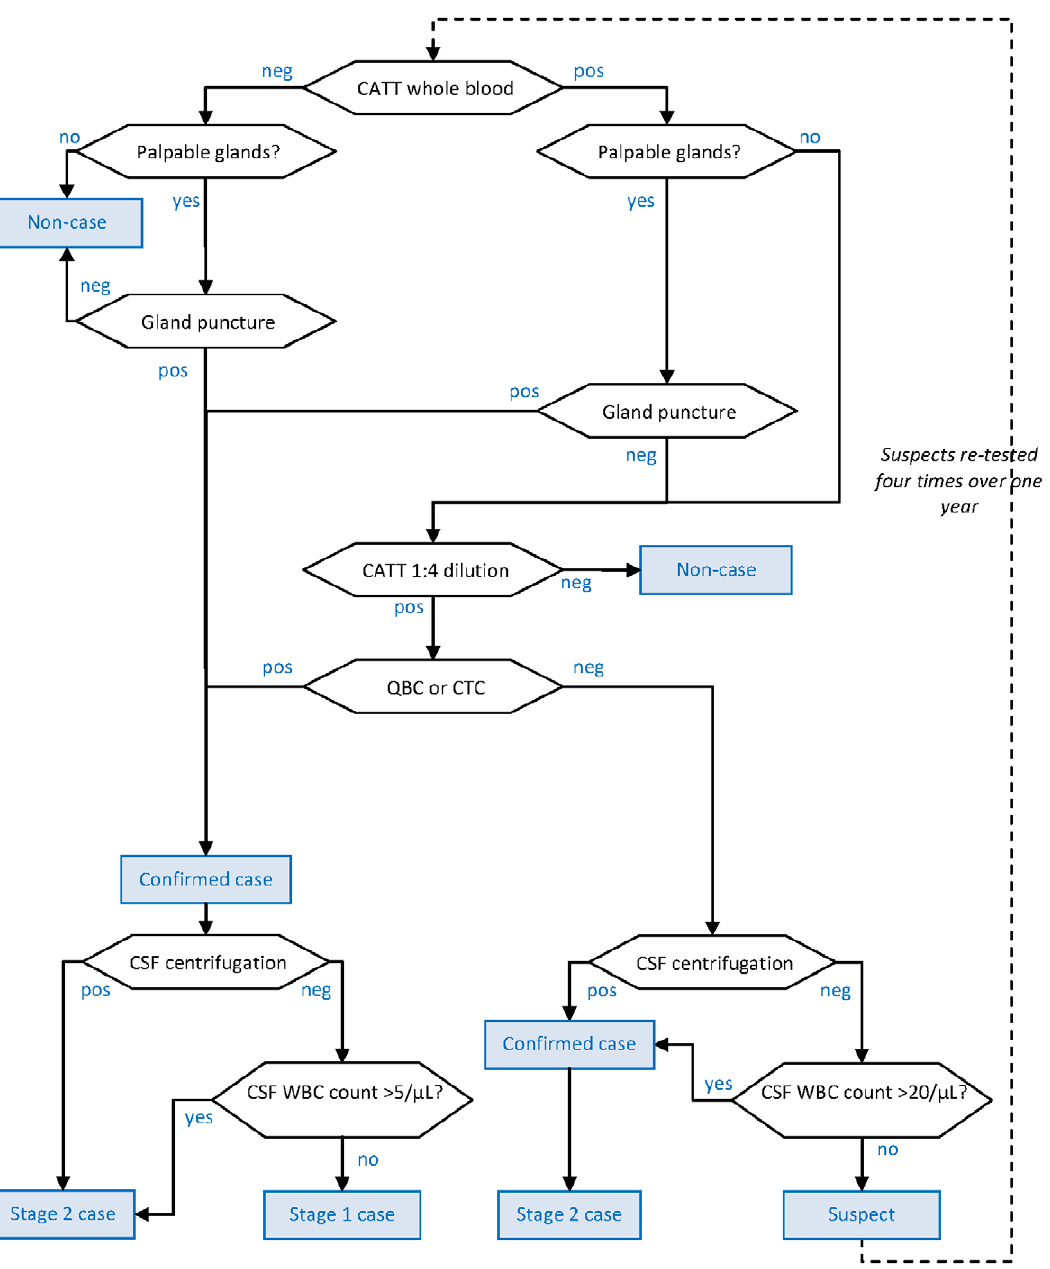
Figure 2. Diagnostic algorithm used in the Kiri, Southern Sudan programme (beginning of programme). Hexagonal boxes indicate tests. Square, blue-shaded boxes indicate points at which a decision on the patient is reached.